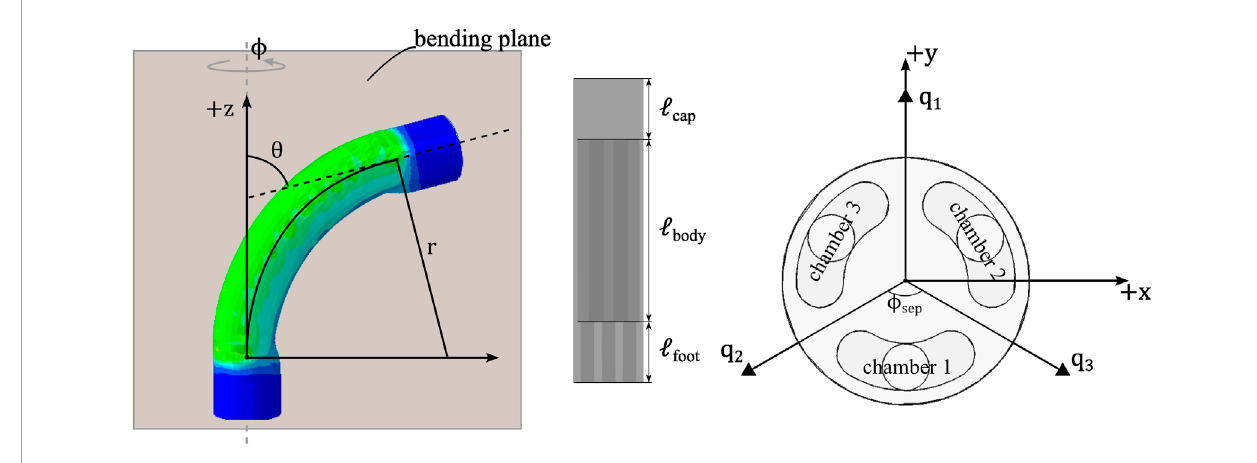
FIGURE 4 Kinematic representation of the PCC segment for the soft pneumatic endoscope